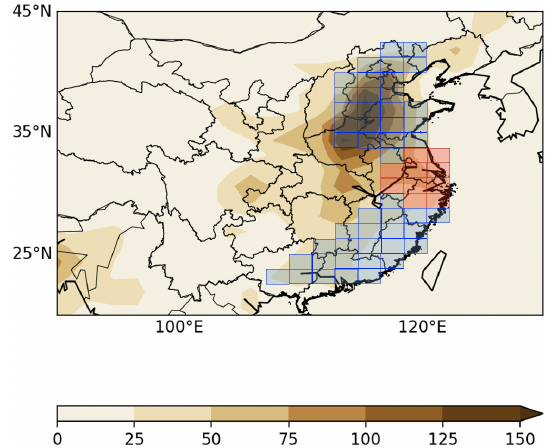
Figure 8. Spatial distribution of the winter mean daily PM 2 . 5 con- centrations (µgm − 3 ) simulated by UKESM1 across China during DJF 2014–2018 (shaded colours) and UKESM1 model grid cells representing northern China (top blue grid cells), YRD (red grid cells), and southern China (bottom blue grid